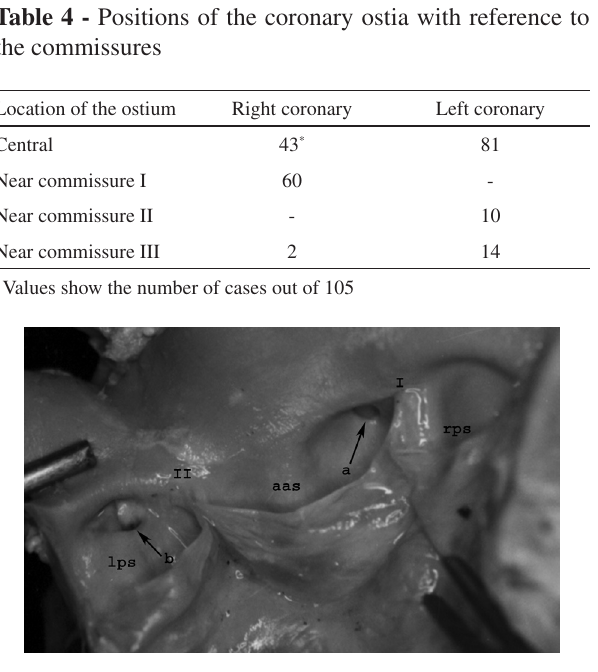
Table 4 - Positions of the coronary ostia with reference to